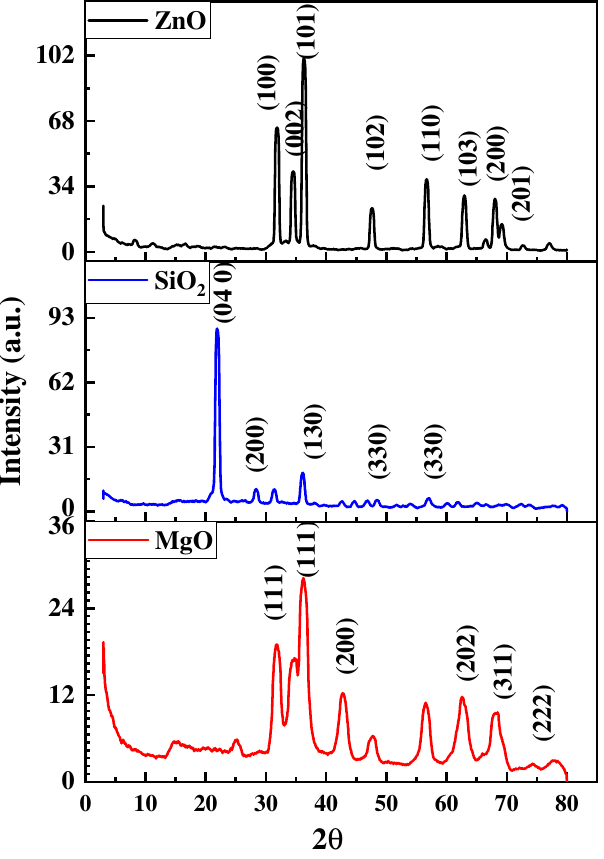
Figure 1. The X-ray diffraction profile of NPs synthesized using the lemon peel